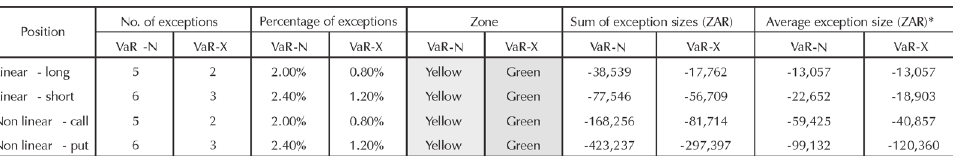
Backtesting results for 99 per cent DVaR for Top40 positions over most recent 250 trading days in our data